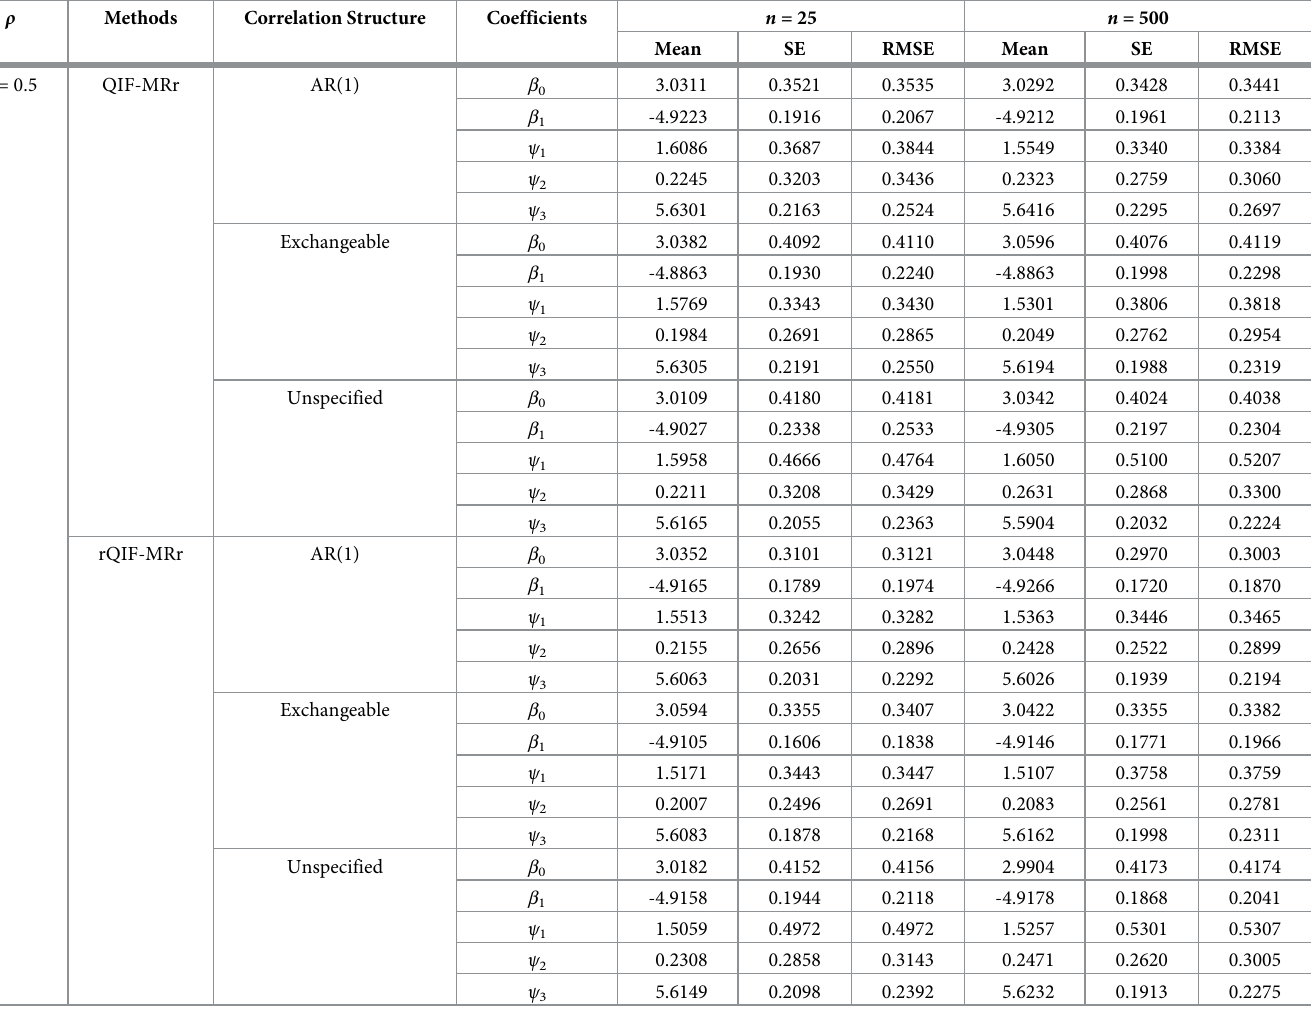
Table 3. Parameter estimation of the misspecification working correlation structures for the QIF-MRr and rQIF-MRr at medium correlation value, ρ = 0.5. ρ Methods Correlation